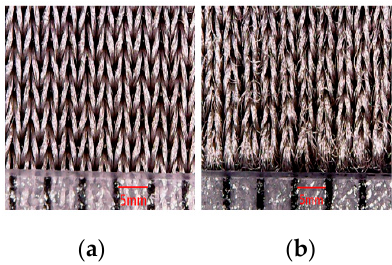
Figure 8. Surface morphology of silver-plated electrodes ( a ) before washing; ( b ) after 50 washing cycles.